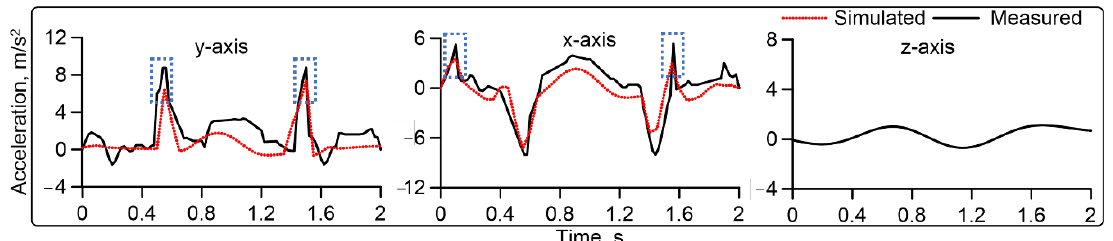
Figure 9. Simulated and measured acceleration curves of the gripper in the x -, y -, and z -axis directions for one complete picking cycle. Table 7. Comparison of simulated and measured average acceleration of the gripper. Axis